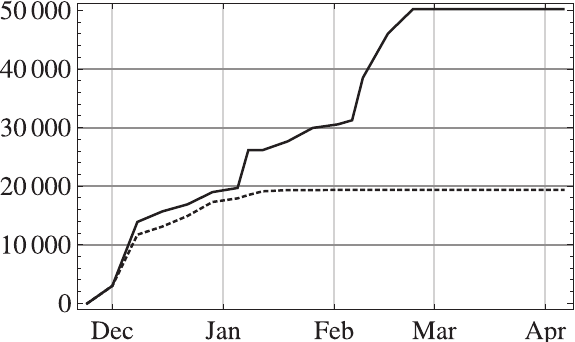
Fig . 4. – Accumulated amount of emulsified oil and algae (metric tons) recovered at sea as a function of time (continuous line) and amount recovered by oil recovery vessels (dashed line). Adapted from